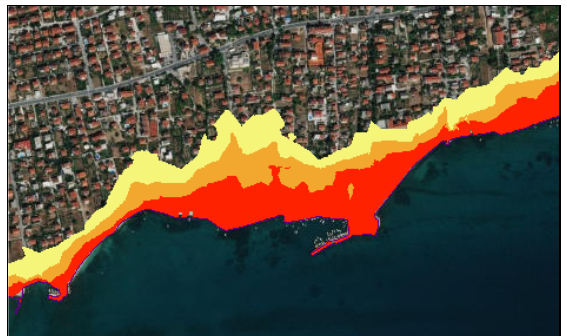
Figure 2. Hazard zone 1 (red), 2 (orange) and 3 (yellow) showing areas of 1, 2 and 3 meters above sea